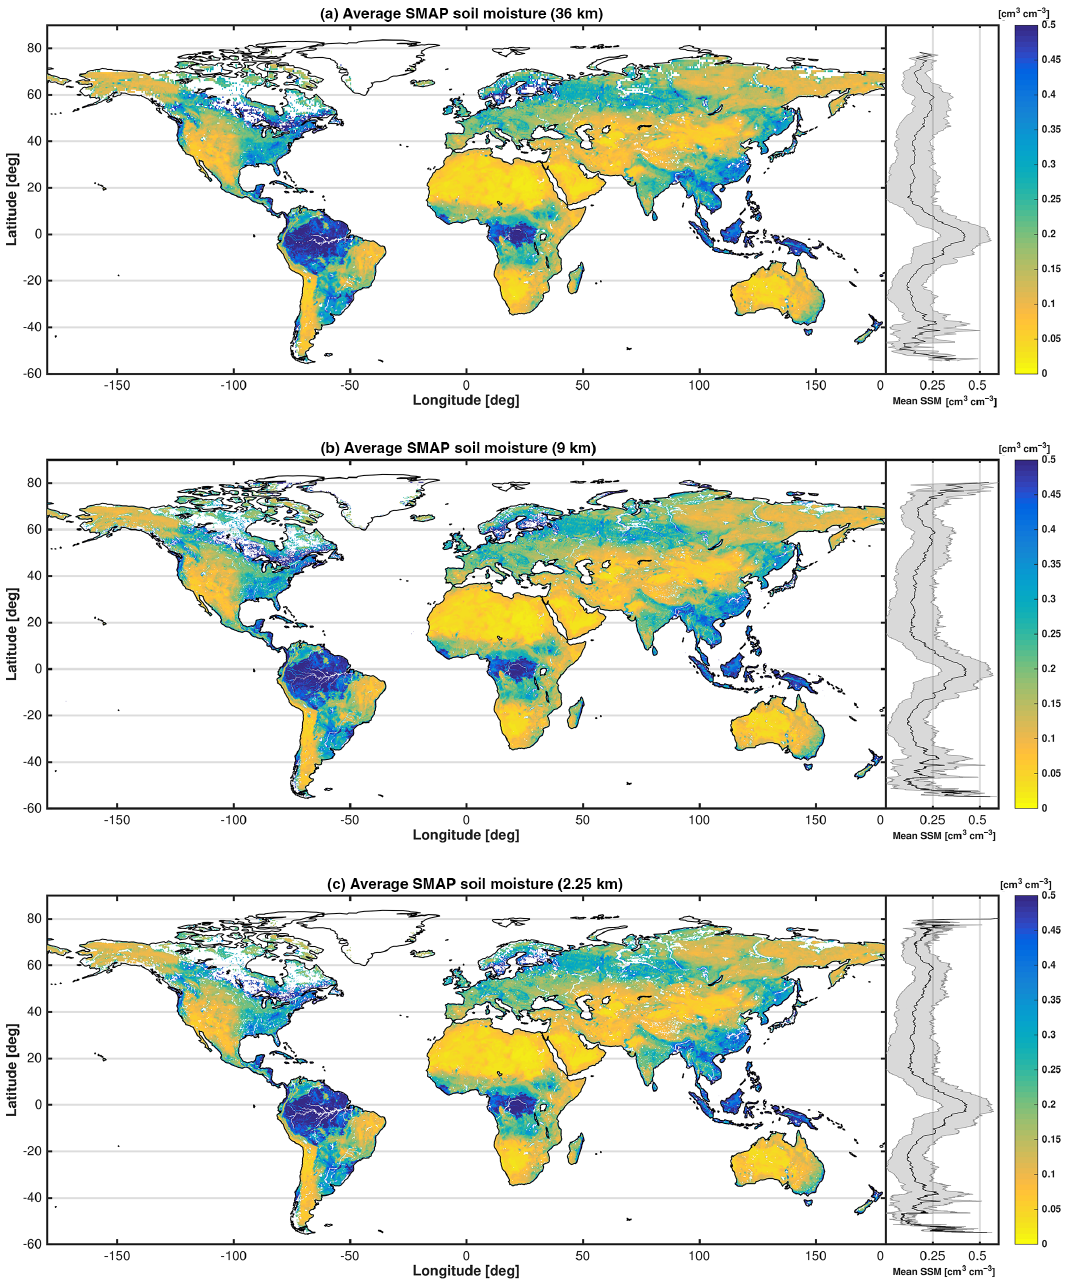
Figure 5. Average soil moisture at 36km (a) , 9km (b) and 2.25km (c) between April 2015 and March 2017. The shaded plot on the right side of each panel shows the mean and 1 standard deviation of soil moisture at each